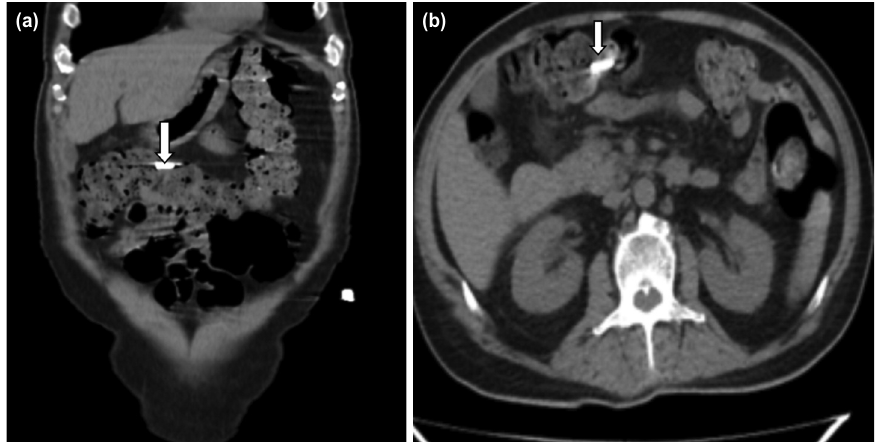
(a) Showing coronal cut of abdominal CT scan which shows the migrated screw from cervical plate as pointed with white arrow, Fig. 3: (b) showing cross-sectional cut of CT scan with migrated screw marked with a white